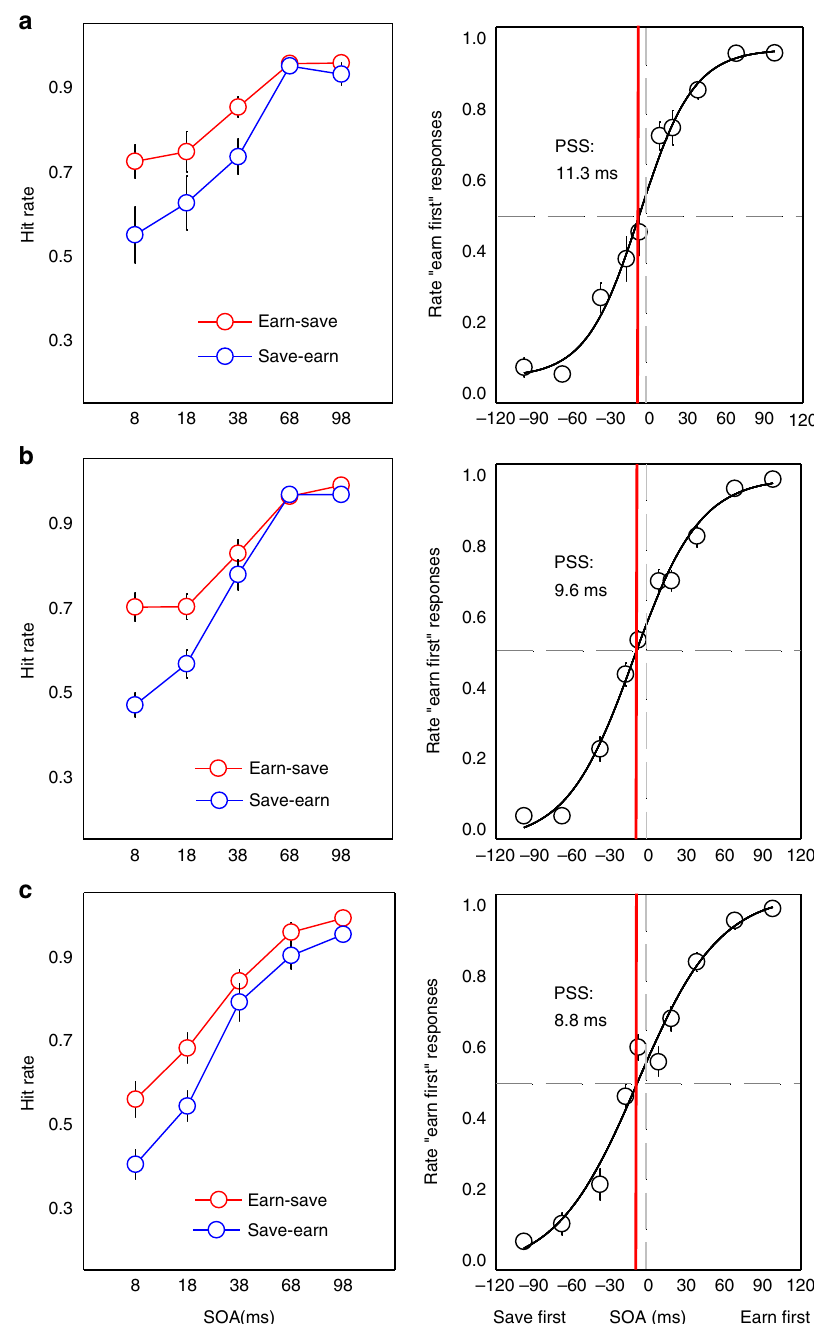
Fig. 4 Temporal-order judgments for color cues predicting earning and saving. Top row ( a ): temporal-order judgment (TOJ) in experiment 1a. Left panel: the average hit rate for earn and save from the “ earn-save ” and “ save-earn ” trials as a function of stimulus-onset asynchrony (SOA). For the pairs in the trial, the fi rst stimulus name appeared earlier physically; right panel: earn-save trials. Line is estimated point of subjective simultaneity (PSS) with leftward shift revealing save colors are judged to appear later. Middle row ( b ), TOJ in experiment 1b; and bottom row ( c ), TOJ in experiment 1c. For all, error bars indicate standard errors of the mean (SEM). See text for